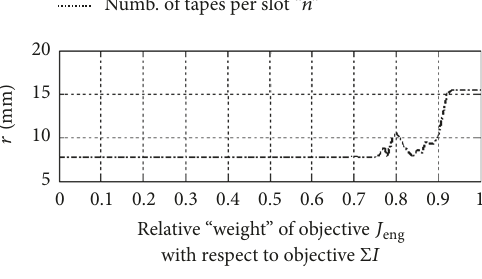
Figure 7: Pareto frontier represented as a function of the relative “weight” of one objective with respect to the other for the 3 slots’ = 3) . Top panel: values of the two objectives. configuration (𝑛 slots Bottom panels: values of the respective design variables.